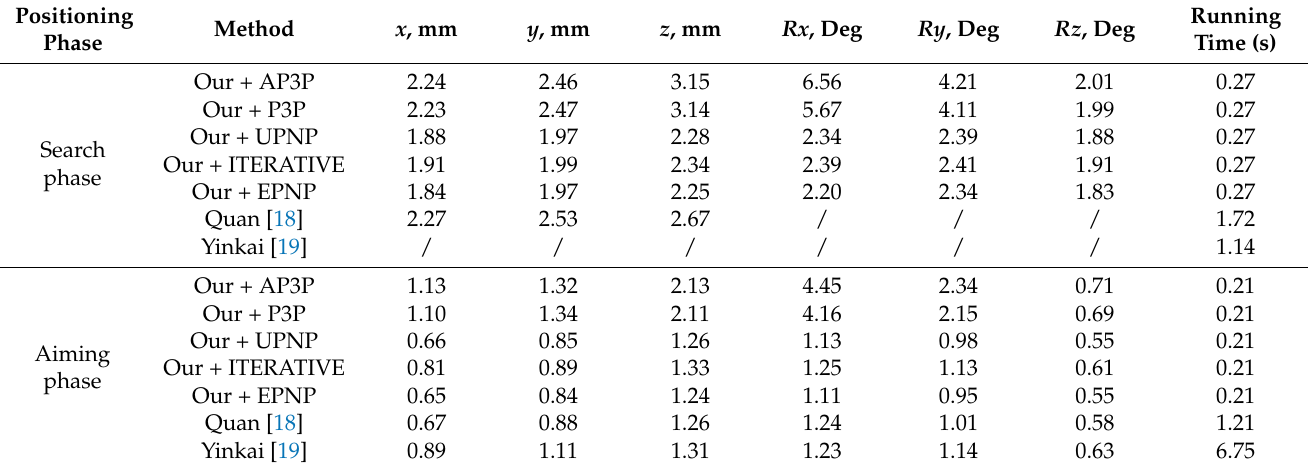
Table 7. Comparison of pose positioning